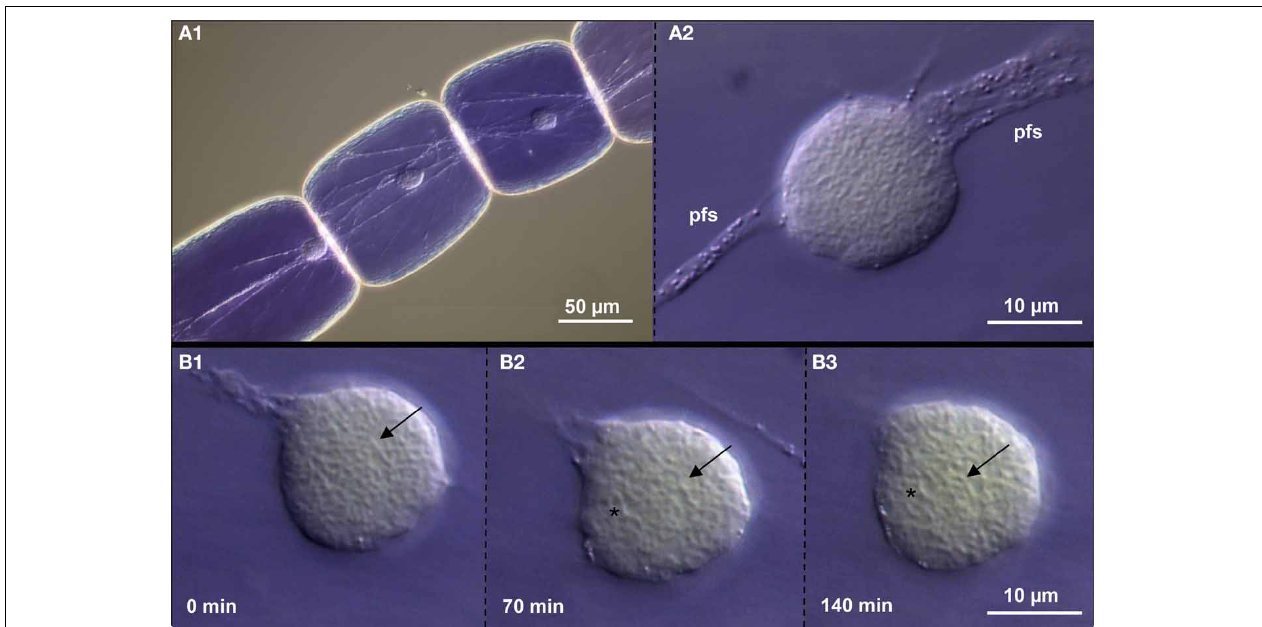
FIGURE 6 | Chromatin dynamics in living Tradescantia paludosa nuclei. (A) The position of nuclei in stamen hair cells (A1) is kept by attached plasma fiber strands (pfs) (A2) . (B) Compared to the starting point of time